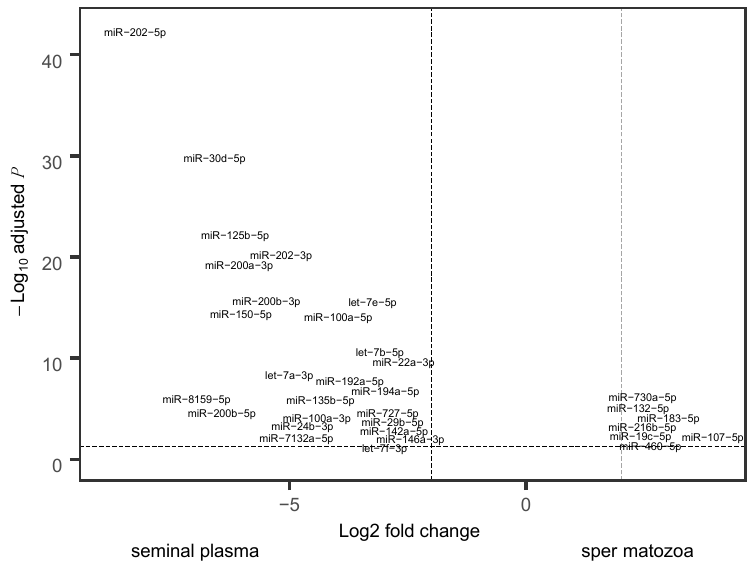
Figure 4. Differentially accumulated miRNAs between spermatozoa and seminal plasma fractions of Atlantic salmon sperm. Vertical and horizontal dashed lines show the fold change cut-off of 2 and adjusted p -value of 0.05, respectively. Red and labeled dots represent differentially accumulated miRNAs between the spermatozoa and seminal plasma fractions. FDR = false discovery rate; LogFC = logarithmic fold-change rate.